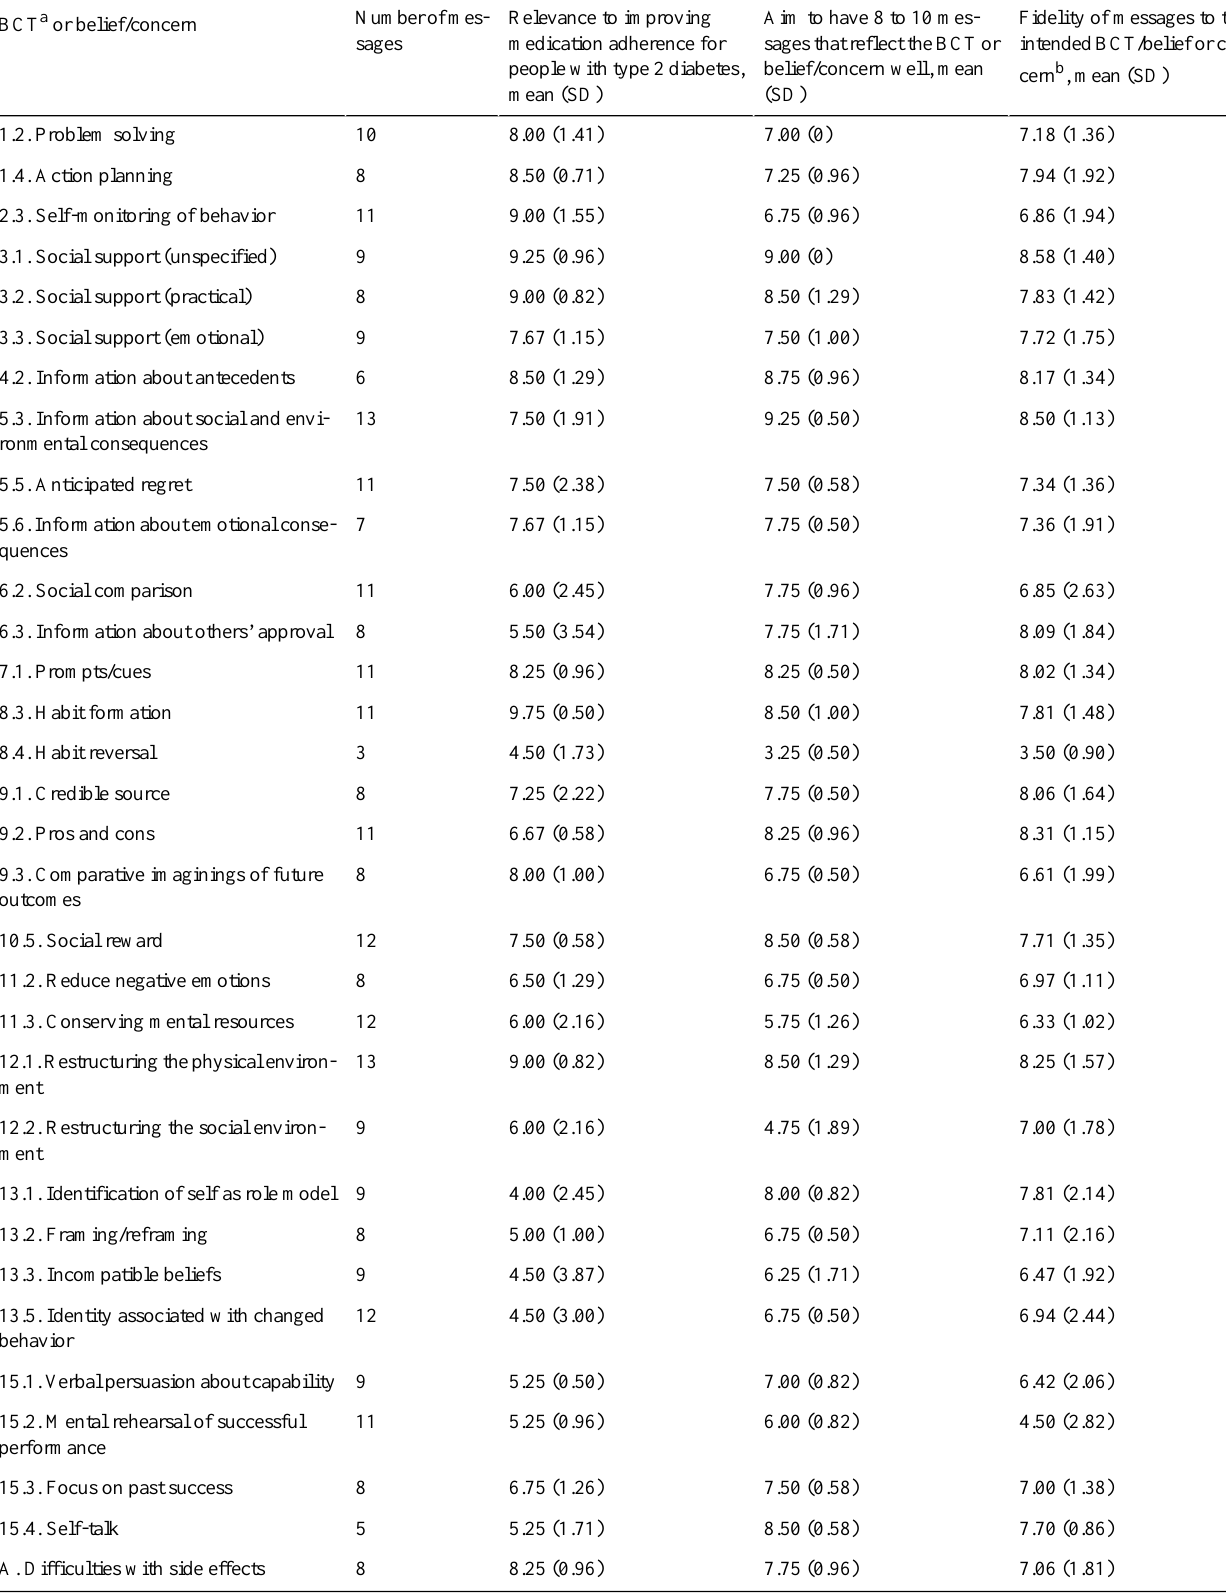
Table 1. Number of messages, mean perceived relevance of the behavior change techniques (BCTs) to medication adherence, mean score for how well the aim of 8 to 10 messages that reflected the BCT well was met, and mean fidelity of messages to the intended BCT or belief/concern from study 1. BCTs are identified through the codes from BCT v1 taxonomy [15] and beliefs and concerns are labeled A through